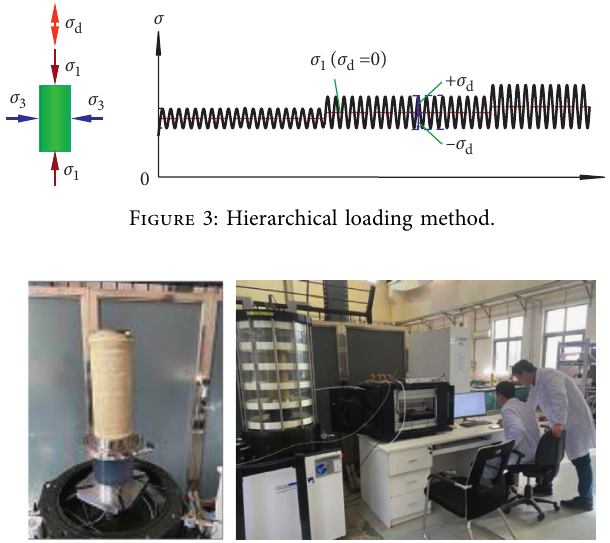
Figure 4: GDS large scale cyclic triaxial test of coarse-grained